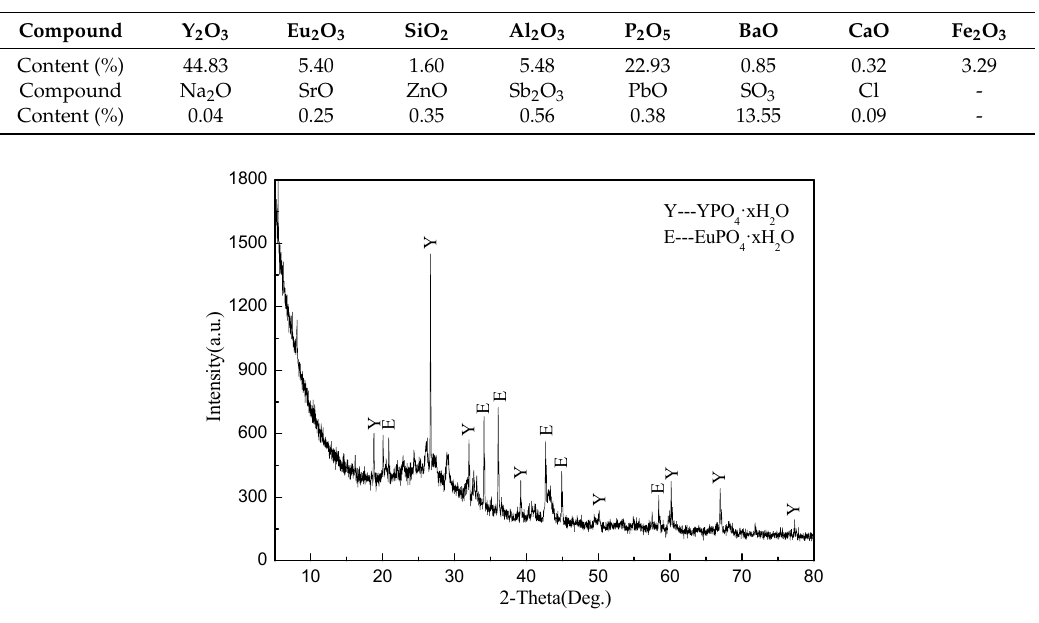
Table 4. Main chemical composition of the solid precipitation.